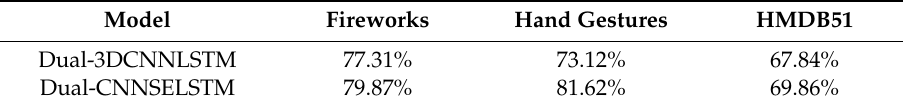
Table 1. Testing the accuracies of both models with the three experimental datasets.